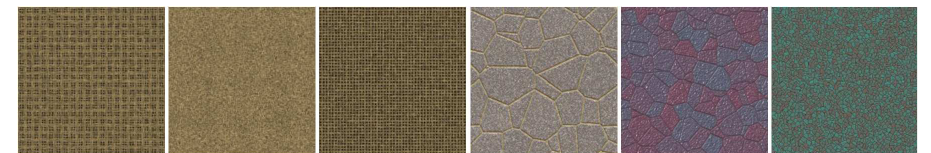
Figure 14. Example textures created by